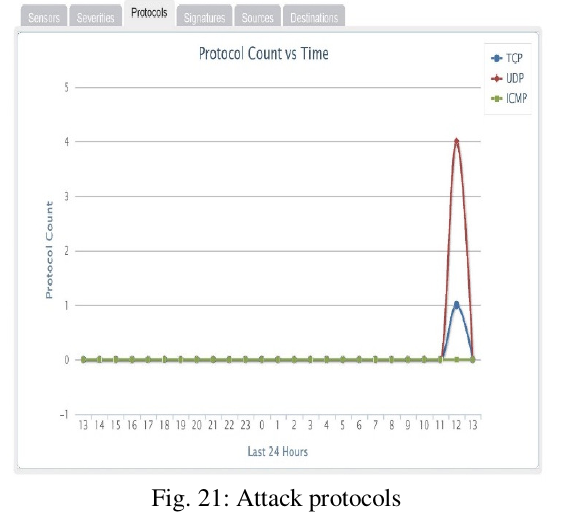
Fig. 21: Attack protocols